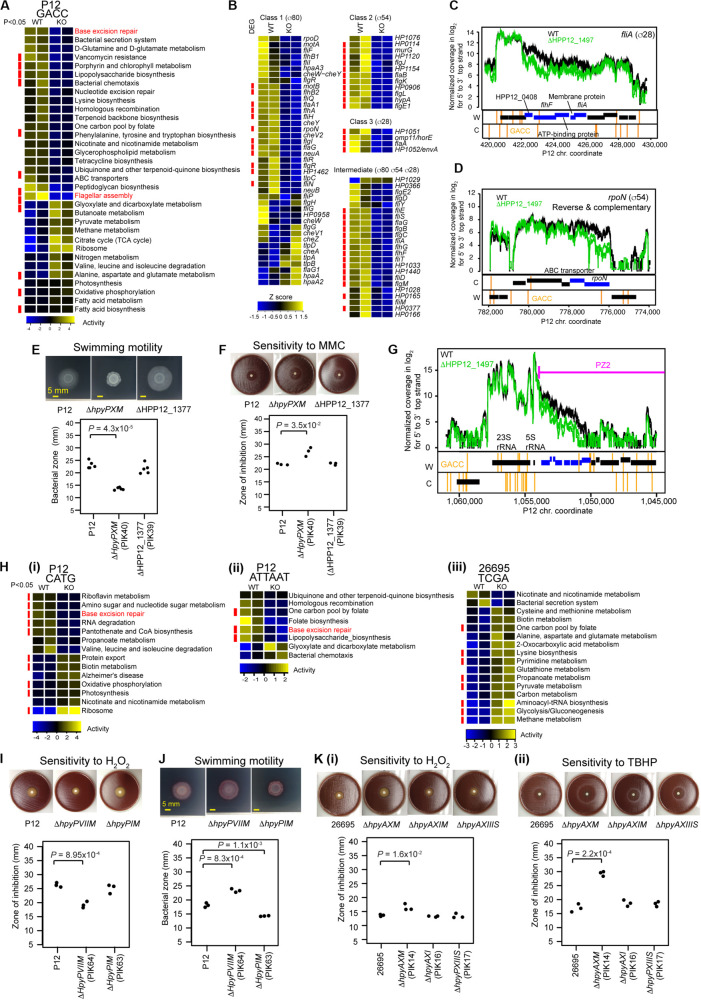
Transcriptome and phenotype changes in methyltransferase knockouts. (A) Transcriptome changes at the pathway level in ΔhpyPXM. Top 33 KEGG pathways with P < 0.1 (n = 2) in Welch’s t-test are shown. A pathway category with P < 0.05 is indicated by a red side bar. (B) Shut down of motility regulation in ΔhpyPXM revealed by transcriptome changes at the gene level. Read count was scaled to Z-score. A category of enrichment (P < 0.05) is indicated by a red side bar. (C) Read coverages in the parent and the knockout (upper panel) and GACC motif distribution (lower panels) around fliA (for sigma28). (D) Read coverages and GACC distribution around rpoN (for sigma54). A blue box indicates a differentially expressed gene. A vertical line indicates a copy of the methylation motif. (E) Swimming motility. Significance of the difference was evaluated by two-tailed Welch’s t-test. (F) Sensitivity to mitomycin C (MMC). (G) Transcriptome changes at the pathway level in ΔhpyPIM (CATG), in ΔhpyPVIIM (ATTAAT), and in ΔhpyAXM (TCGA). (H) Increased oxidative stress resistance in ΔhpyPVIIM (ATTAAT). (I) Increased swimming motility in ΔhpyPVIIM (ATTAAT). (J) Reduced oxidative stress resistance in ΔhpyAXM (TCGA). (K) (i) Hydrogen peroxide. (ii)
tert-butyl hydrogen peroxide (TBHP). Statistical significance of the difference was evaluated by two-tailed Student’s t-test.